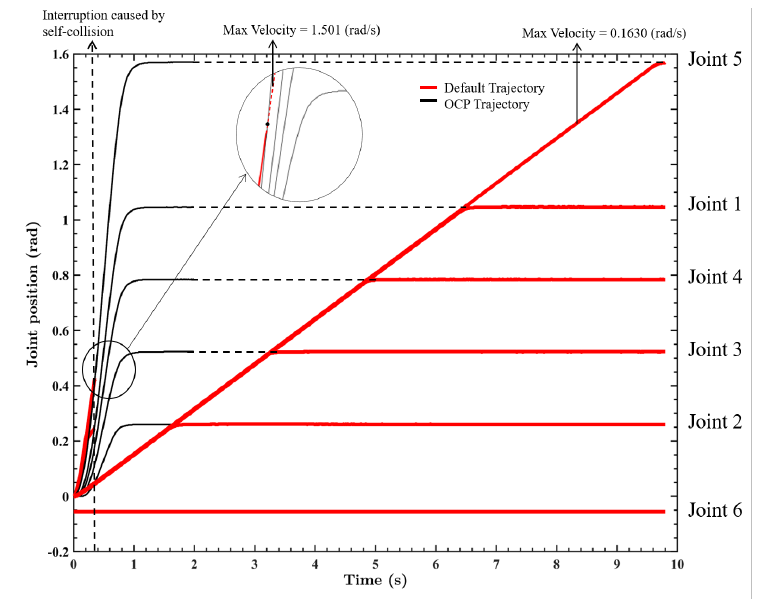
Figure 6. The OCP trajectory and default trajectory with different maximum velocity in the experiment.